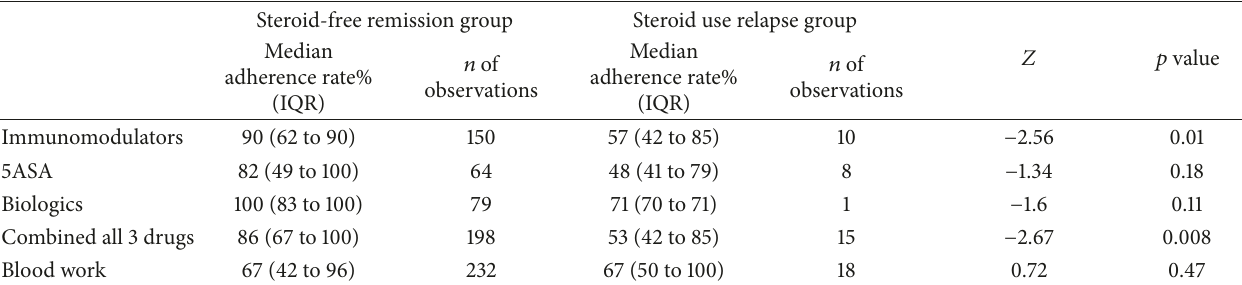
Table 5: Adherence to medication predicts 6-month steroid-free remission rates (using Wilcoxon rank-sum (Mann–Whitney) test with steroid-free remission as dependent variable and adherence rate as independent